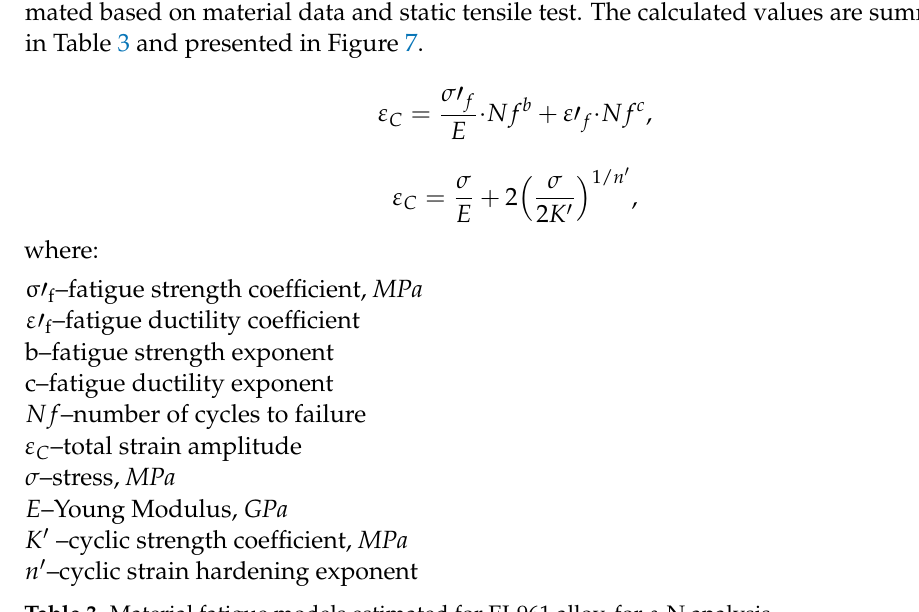
Table 3. Material fatigue models estimated for EI-961 alloy, for ε -N analysis. Name of the